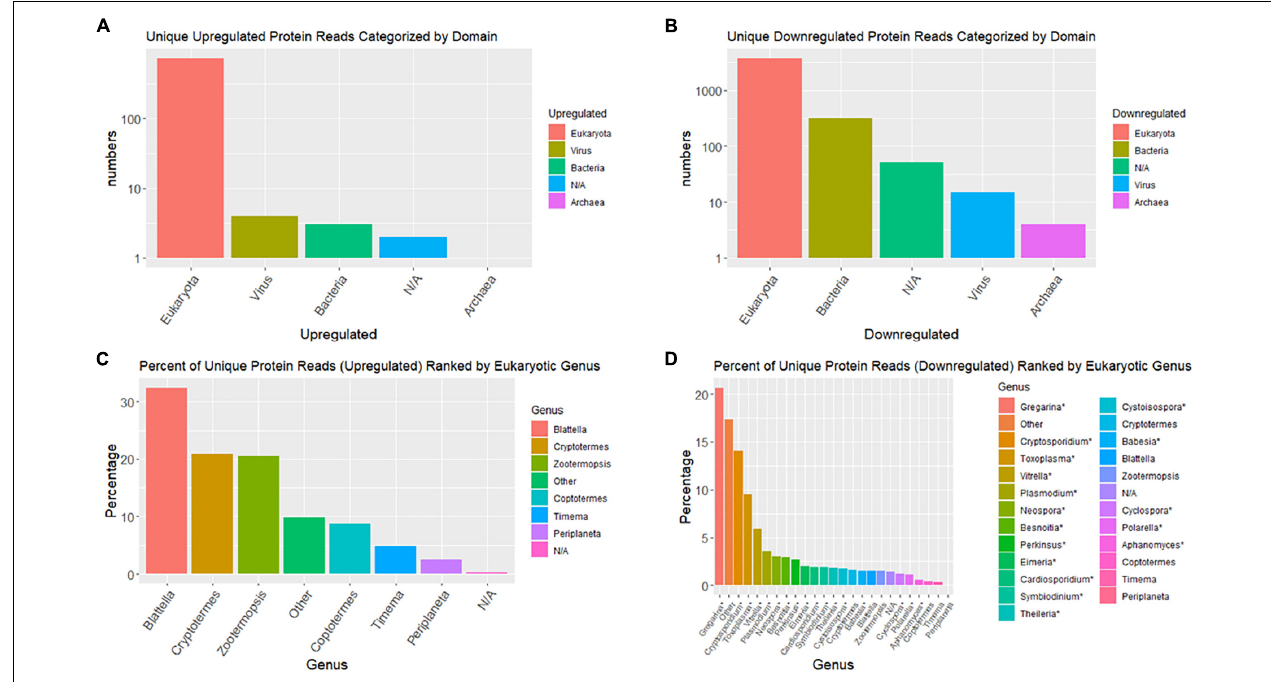
FIGURE 4 | Bar graphs summarizing top taxonomic matches of top BlastX hits for differentially expressed contigs. (A,B) Are domain-level taxonomic matches and (C,D) are genus-level. (A,C) Are upregulated contigs and (B,D) are downregulated.